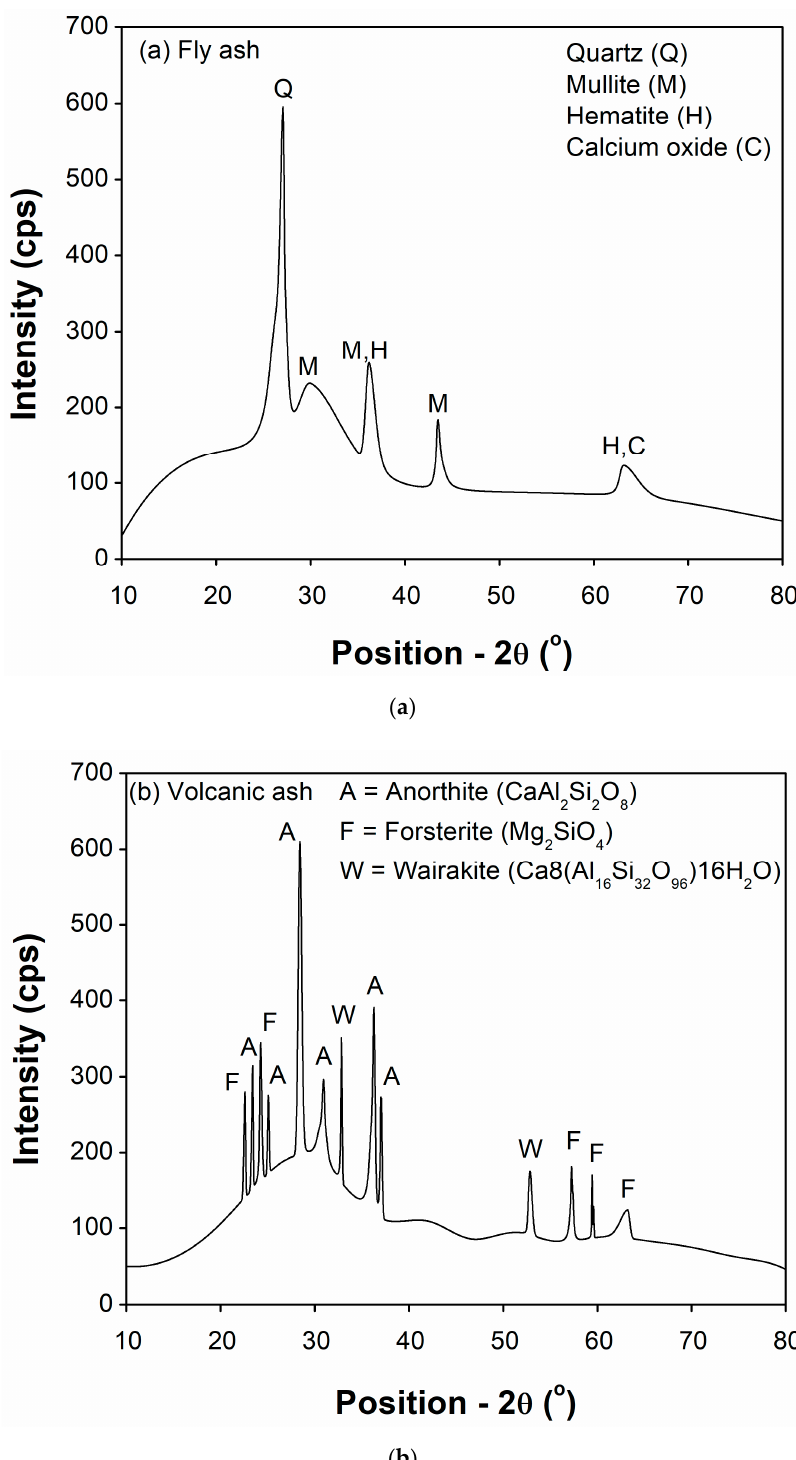
Figure 6. XRD patterns of pozzolanic materials used in this study ( a ) FA, and ( b ) VA.